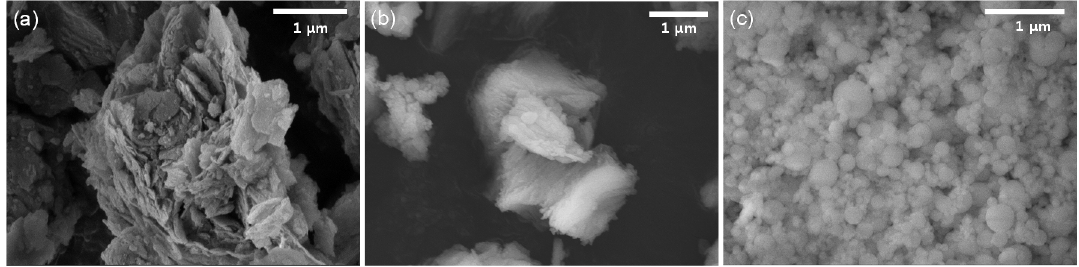
Figure 1. Scanning electron microscope (SEM) image of used materials: kaolinite clay ( a ), hydrated lime ( b ), and SF ( c ).